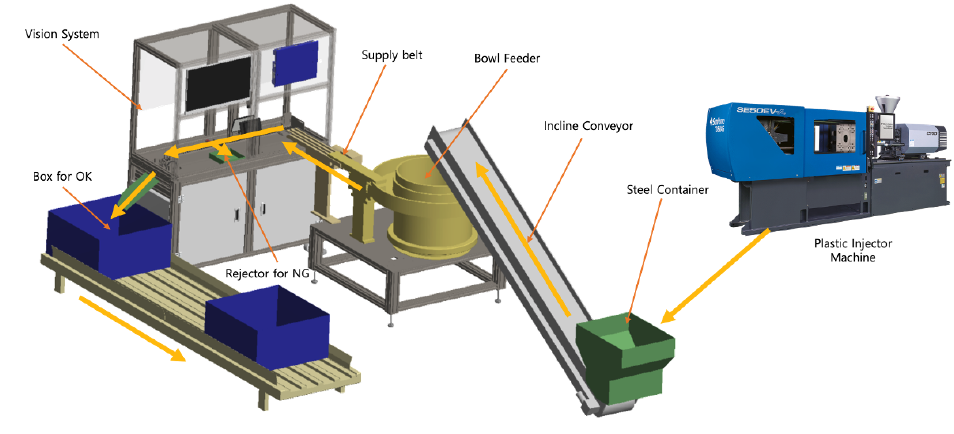
Figure 7. Layout of the surface-inspection system based on deep learning.